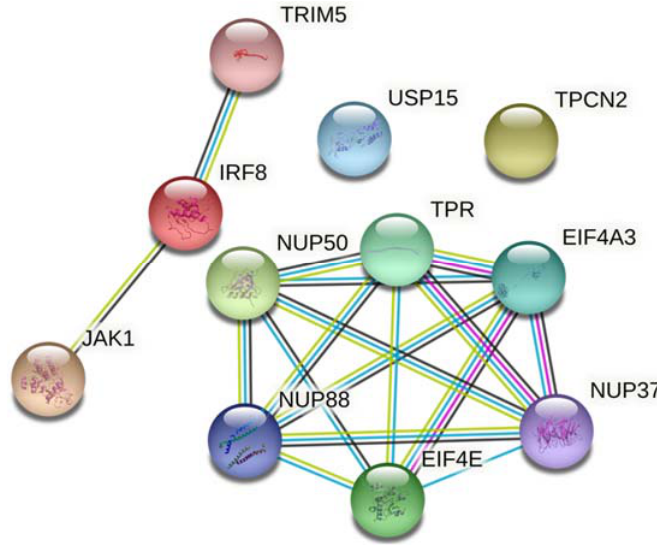
Figure 1. Interactions among the products of genes whose SNPs were associated with endemic pemphigus foliaceus. The interaction map was drawn using STRING (stringdb.org; accessed 2 December 2021). The edges represent protein–protein association. Blue and purple edges indicate interactions with known co ‐ occurrence and experimental evidence, respectively. Yellow and black edges indicate textmining and co ‐ expression evidence, respectively. Filled nodes represent proteins whose 3D structure is known or predicted, while empty nodes represent unknown 3D structures. The colors of the nodes were selected randomly.